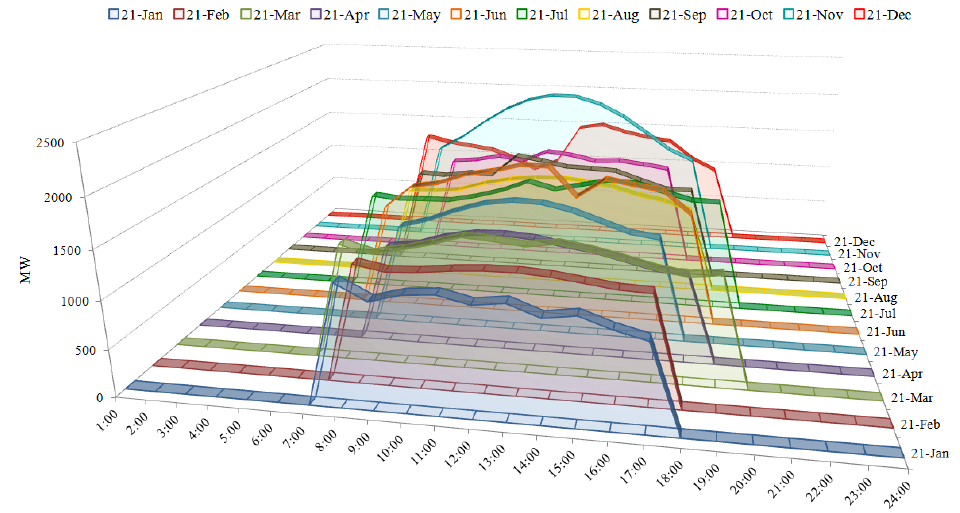
Figure 8. Total power estimation (in MW) be potentially produced from all rooftops within one LiDAR tile that covers the UTSA main campus (calculation for the 21st of each month).